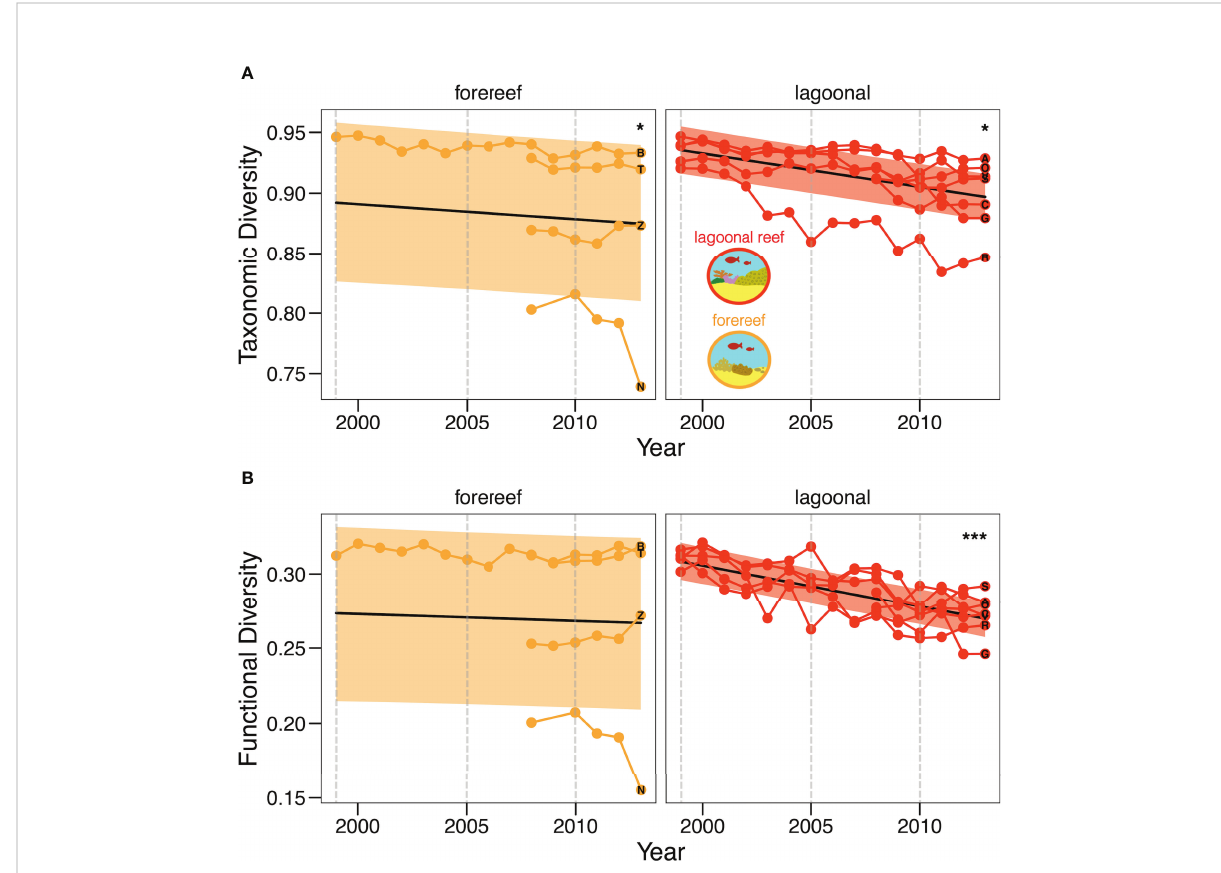
FIGURE 4 Change in reef community diversity over time. Temporal change in lagoonal reef and forereef taxonomic, or coral species, diversity (A) and functional, or coral trait, diversity (B) . Black lines show the predicted trend, coloured lines show the observed trends of individual reef communities and coloured bands represent standard error. Grey, dashed lines mark the years during which bleaching events occurred in Bocas del Toro. Asterisks mark signi fi cant trends (*p <.05; ***p <.001). Letters represent reef locations and mark community diversity in